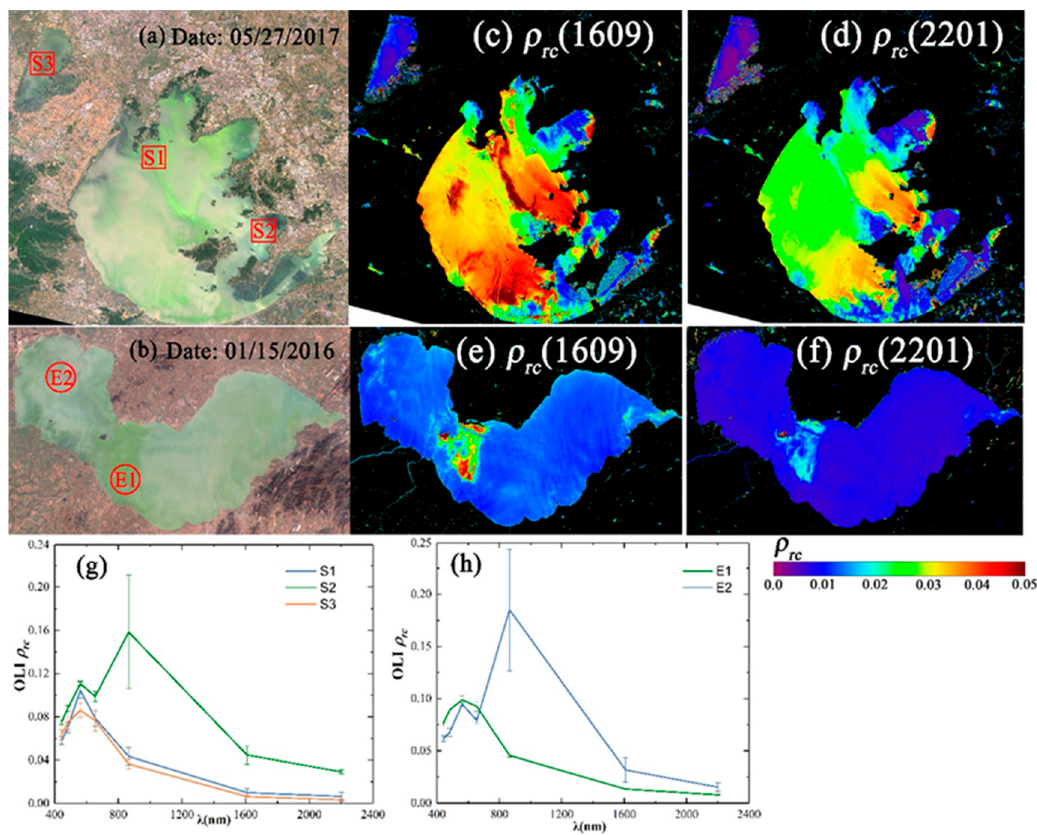
Figure 12. OLI-RGB images and Rayleigh-corrected reflectance ( ρ rc ) images of two SWIR bands in Lake Taihu ( a , c , d ) and Lake Chaohu ( b , e , f ). The Rayleigh-corrected reflectance derived by SeaDAS processing. ( g ) and ( h ) were line graphs of ρ rc value from figure ( a ) and ( b ) (100 × 100 pixel area), respectively.